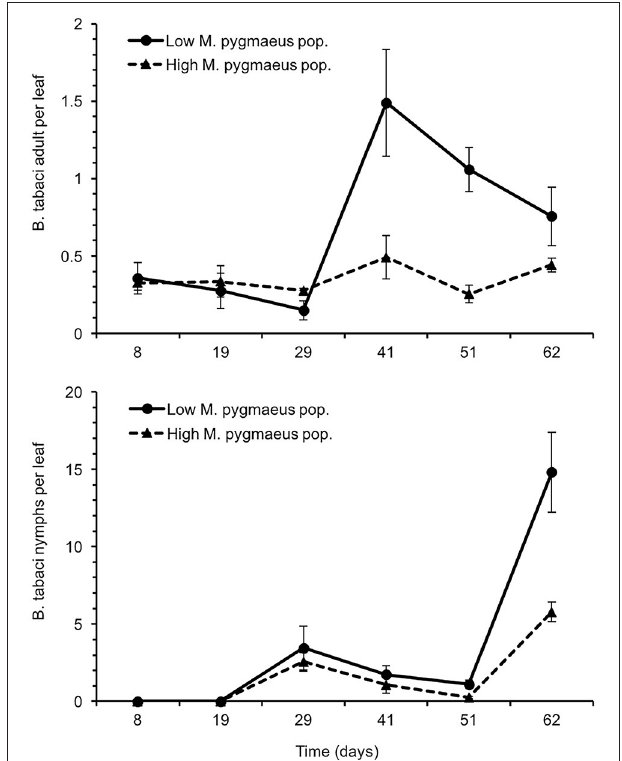
FIGURE 3 | Average number of Bemisia tabaci nymphs (lower graph) and adults (upper graph) ± SE per leaf in tomato greenhouses with low and high M. pygmaeus populations. Time since the introduction of Bemisia tabaci .